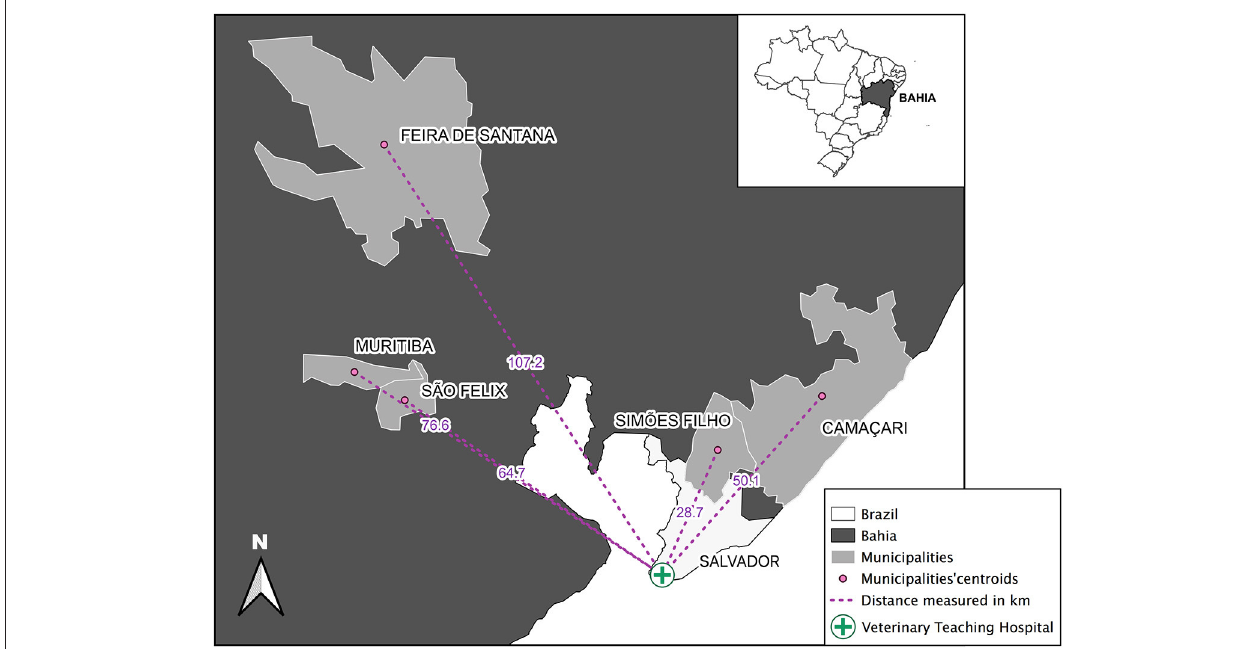
FIGURE 1 | Geographical location of the surveyed municipalities (Feira de Santana, Muritiba, São Felix, Simões Filho, and Camaçari) in the State of Bahia, Brazil. Distance in kilometers (km) from each municipalities’ centroids (pink dots) to the Federal University of Bahia Veterinary Teaching Hospital (green cross) were measured (pink dotted lines). Source: IBGE 2010, Datum: SIRGAS, 2000.